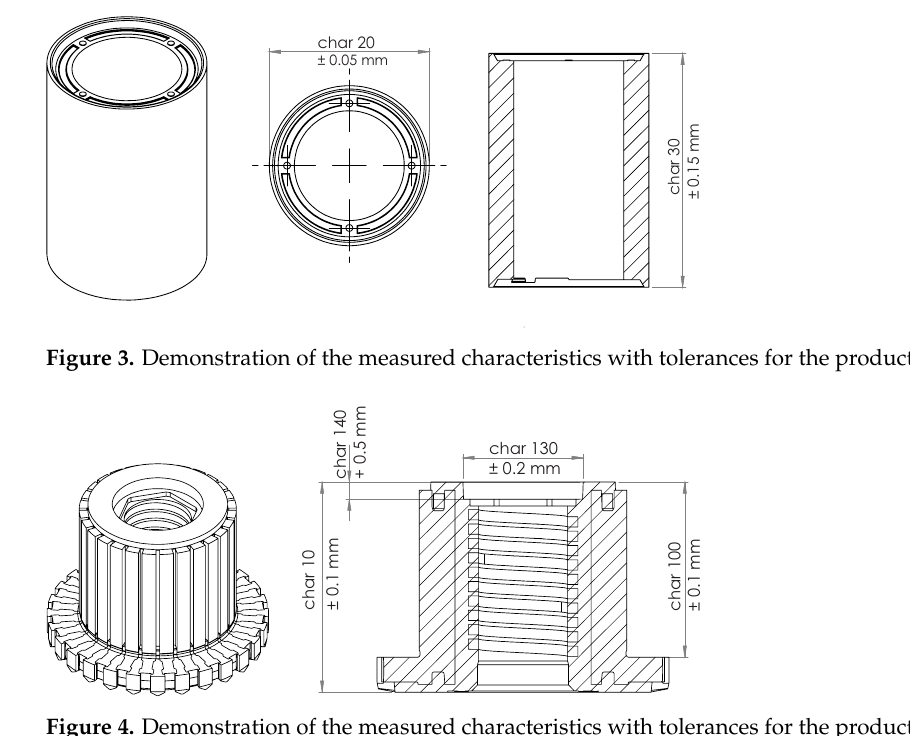
Figure 4. Demonstration of the measured characteristics with tolerances for the product